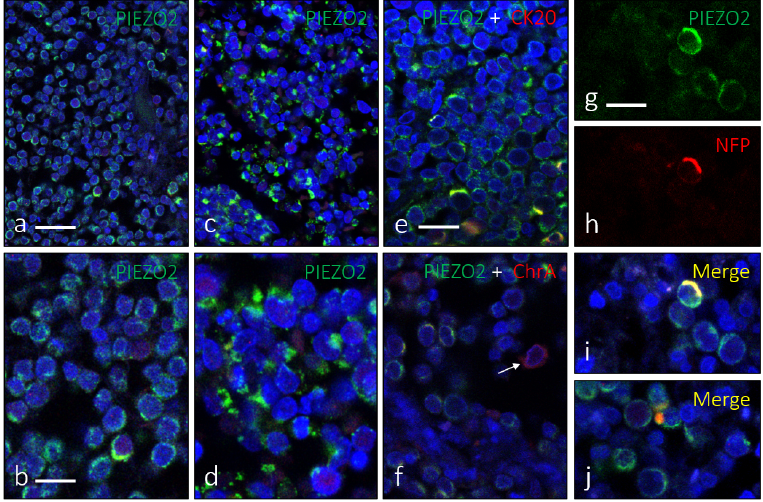
Figure 3. Immunofluorescence for PIEZO2, showing its two morphological patterns: cytoplasmic perinuclear ( a , b ) and dot-like pattern ( c , d ). Co-localization of PIEZO2 with CK20 ( e ) or ChrA ( f ) was regularly observed (merge in yellow). Arrow in ‘f’ indicates a ChrA+/PIEZO2 − cell. The MCC cells were processed for simultaneous detection of PIEZO2 and NFP ( g – j ) only revealed a scarce number of cells showing co-localization of both ( i ), sometimes resembling MC-nerve contact (arrow in j ). Scale bars 50 µm ( a , c ), 20 µm ( b , d – j ).